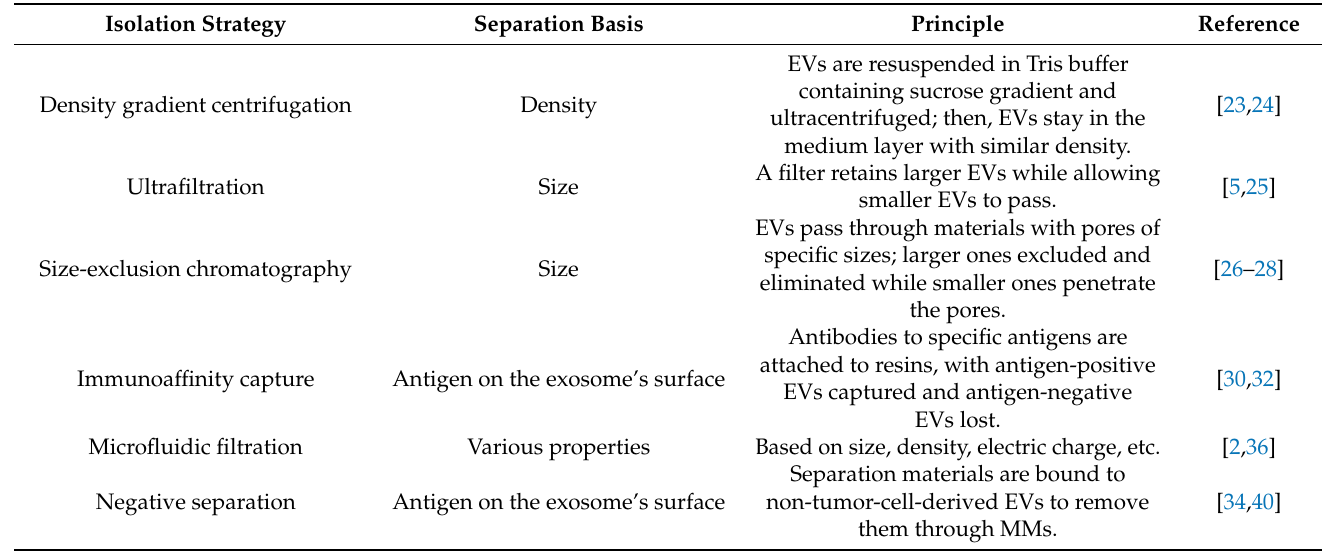
Table 1. Summary of the isolation methods for